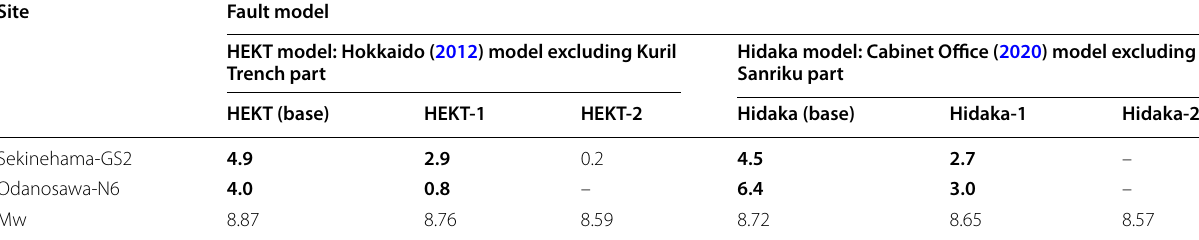
The inundation depth was computed at Sekinehma-GS2, which is the most inland tsunami deposit identified by Ishimura et al. (2022), and at Odanosawa-N6, which is the most inland tsunami deposit identified by Tanigawa et al. (2014). The bold number shows that the most inland tsunami deposits at the two sites could be explained